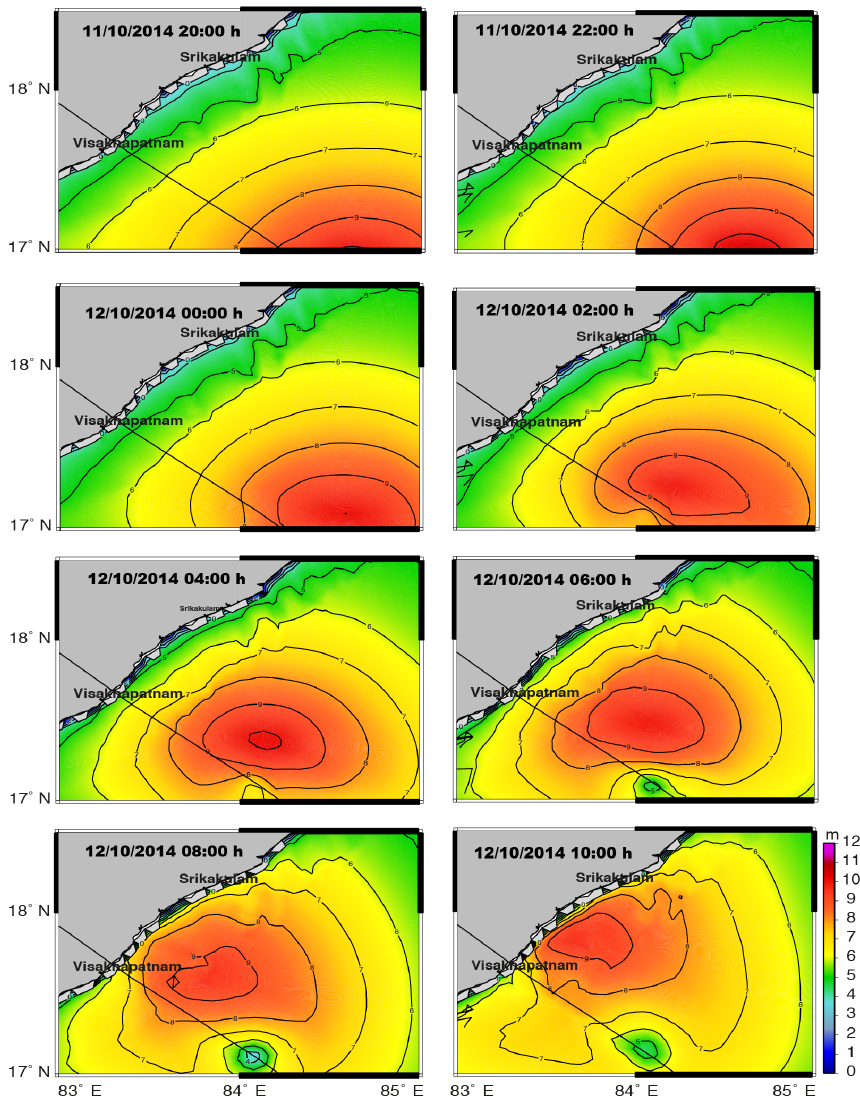
Figure 9. Significant wave heights ( H s ) simulated along the track of the Hudhud cyclone using the coupled ADCIRC + SWAN model (colour contours represent H s in